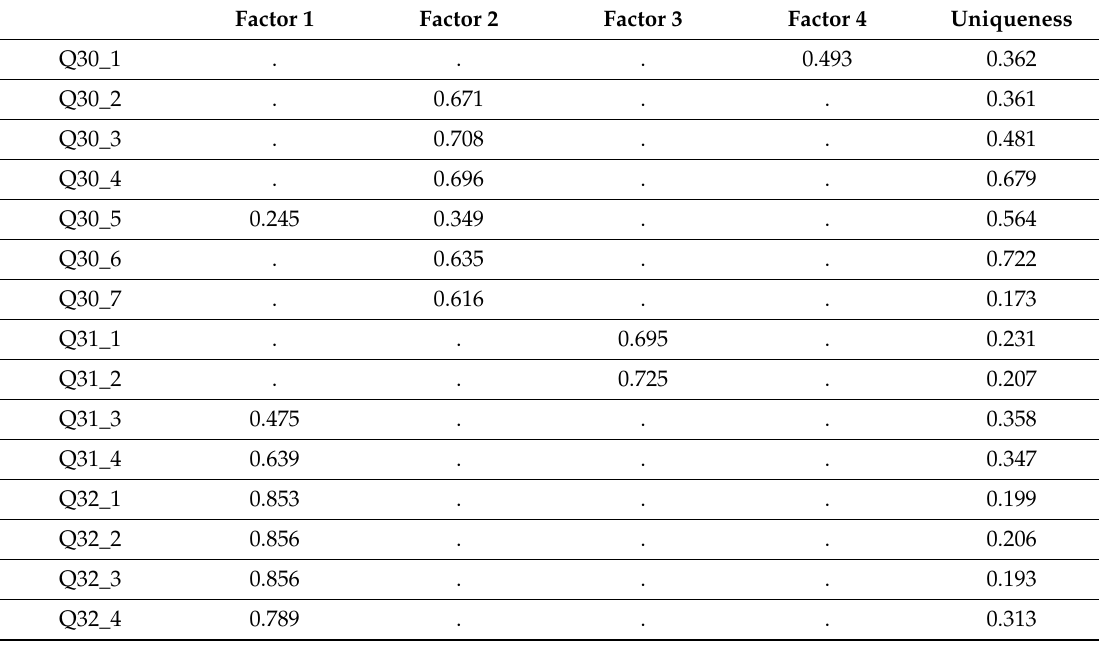
Table 1. Standardized factor loadings for each